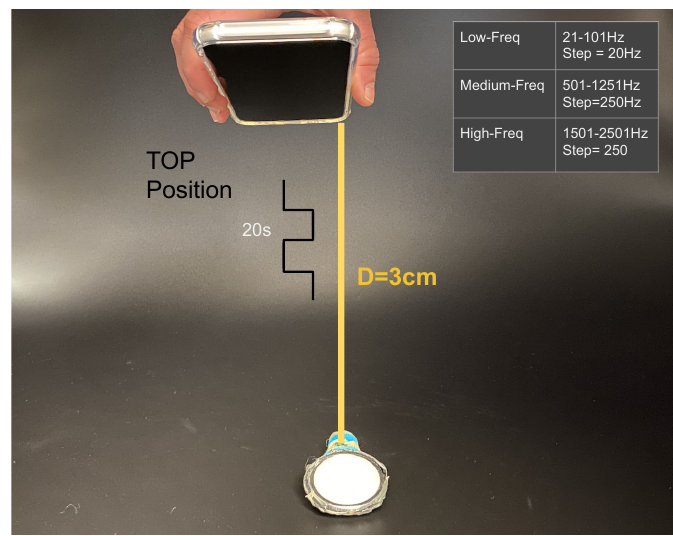
Figure 4. Calibration experiment one, showing sound-source (phone) and stethoscope-head at 3 cm separation. Frequency range of the sound square wave with 20 s duration at each frequency.